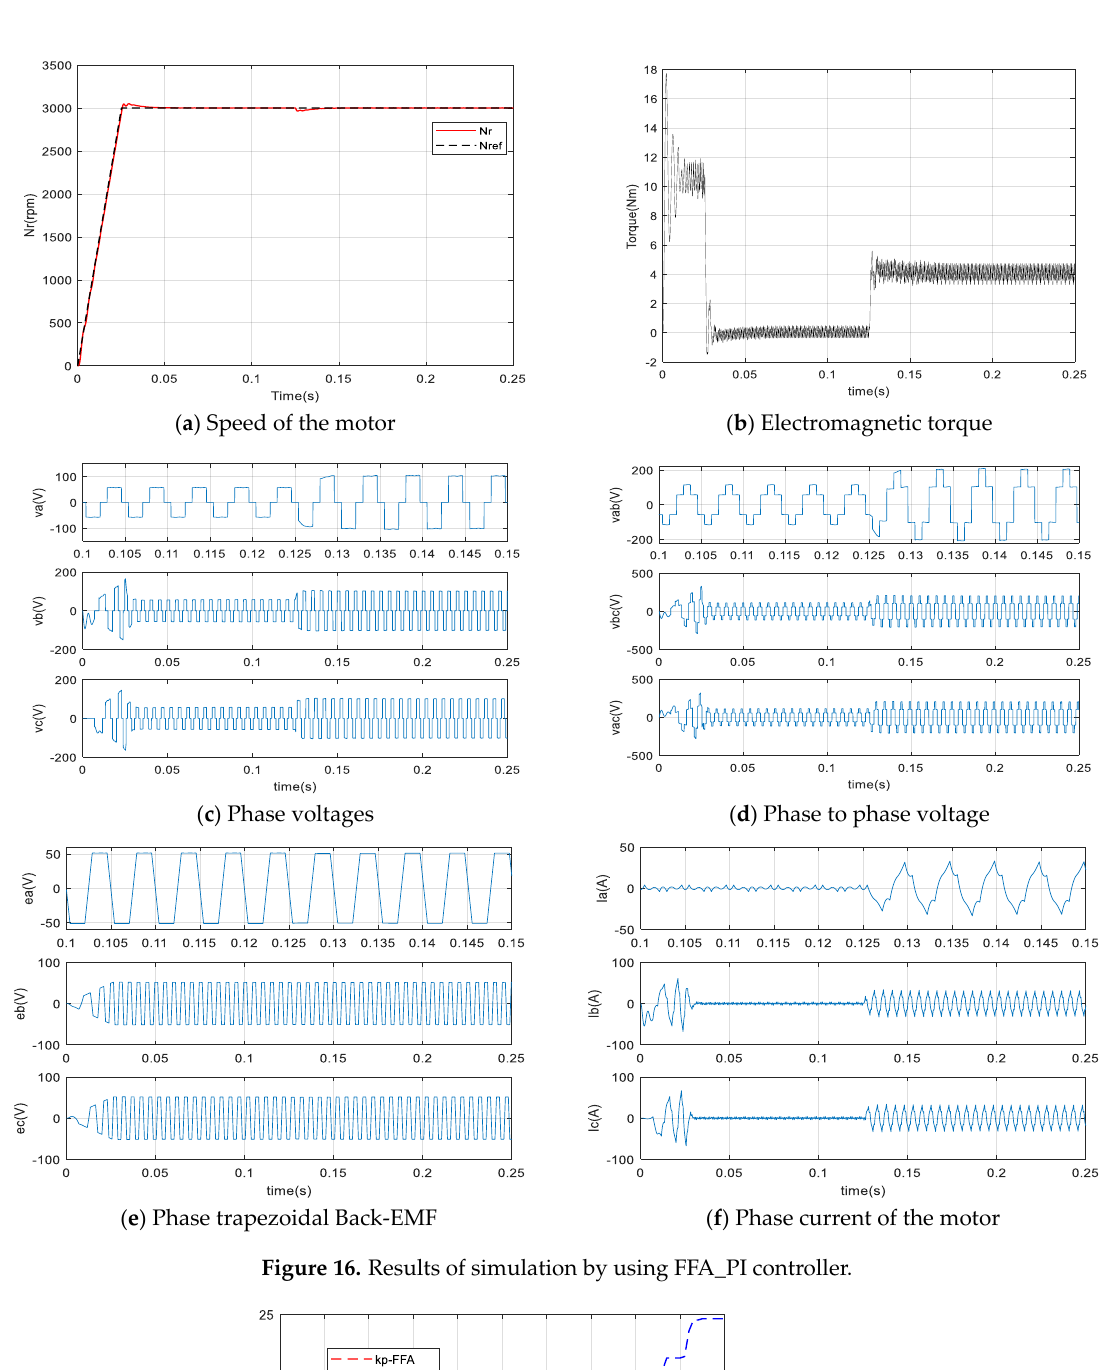
19 of 24 Figure 15. Comparison of speed responses with different algorithms using ISTE criterion: ( a ) original; ( b ) and ( c ) zoomed version.